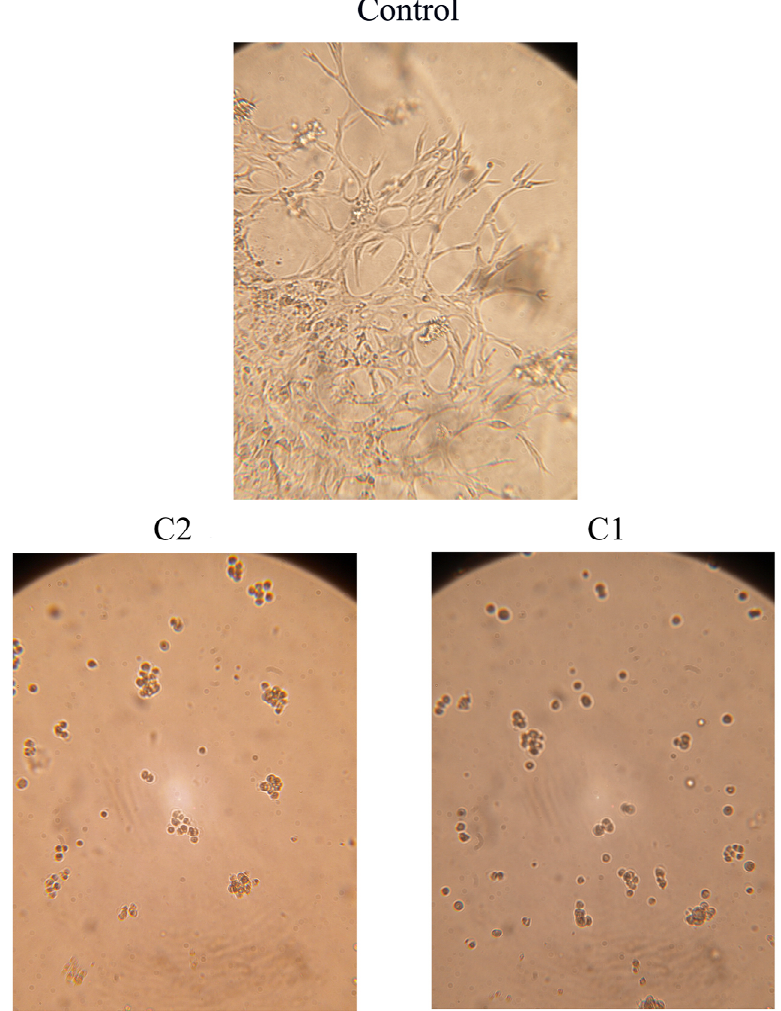
Figure 9. Representative photomicrographs of tube formation assay after 24 h treatments of EA.hy926 cells with IC 20 concentrations of compounds C1 and C2.